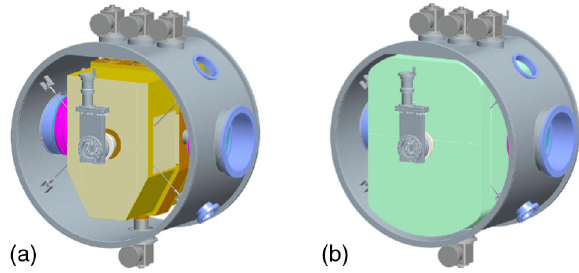
FIG. 22. Cryomodule after installation of thermal shield (a) and outer magnetic shield (b).